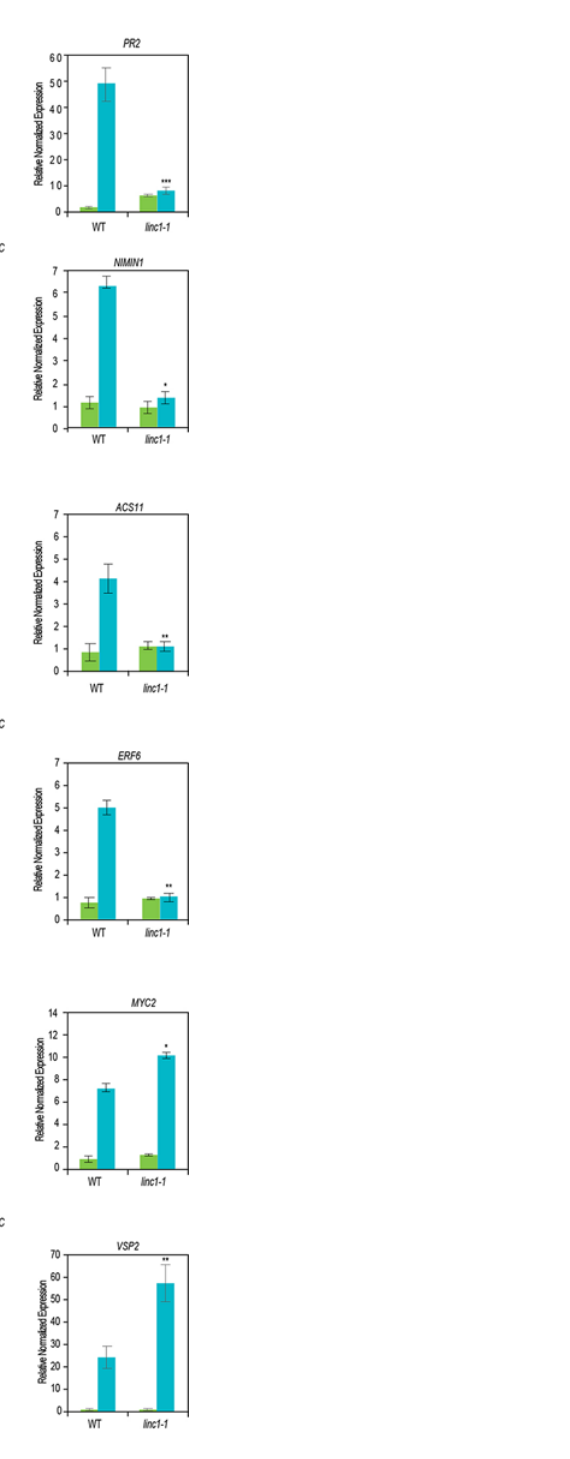
FIGURE 3 | LINC1 modulates defense and hormone related genes. 14-d-old seedlings were treated with Pst hrcC- for 24 h and harvested later to isolate RNA and cDNA preparation. (A) Quantitative RT-PCR (qRT-PCR) analysis of salicylic acid (SA)-related genes regulated by LINC1 . (B) qRT-PCR analysis of ethylene (ET)- related genes regulated by LINC1 . (C) qRT-PCR analysis of jasmonic acid (JA)-related genes regulated by LINC1 . Gene expression was normalized to internal control UBQ10 and actin. The data are shown in (A – C) are means from three biological replicates. Statistical signi fi cance was analyzed by two-way ANOVA, asterisk indicate signi fi cant differences compared to Wild Type, * p ≤ 0.05, ** p ≤ 0.01, *** p ≤